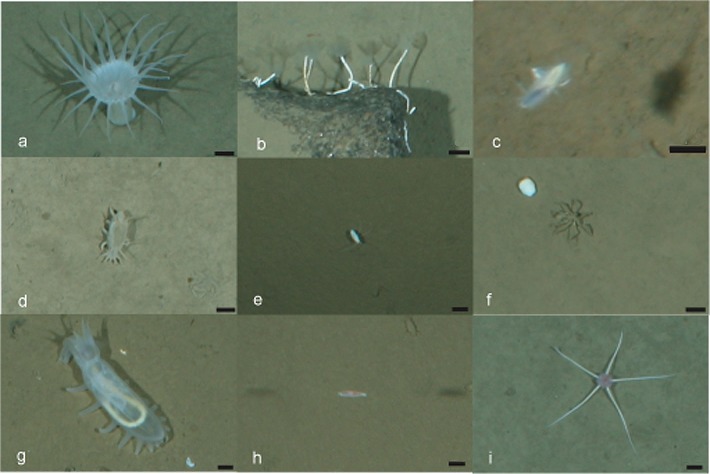
Images of the most abundant taxa.(a) Bathyphellia margaritace (Actiniaria), (b) Hyalopomatus claparedii (Polychaeta), (c) Macellicephalinae gen.sp.5 (Polychaeta), (d) Elpidia heckeri (Holothuroidea), (e) Eurycope inermis (Isopoda), (f) Ascorhynchus abyssi (Pycnogonida), (g) Kolga hyalina (Holothuroidea), (h) Onisimus leucopis (Amphipoda), (i) Ophiostriatus striatus (Ophiuroidea). Scale bar 1 cm.